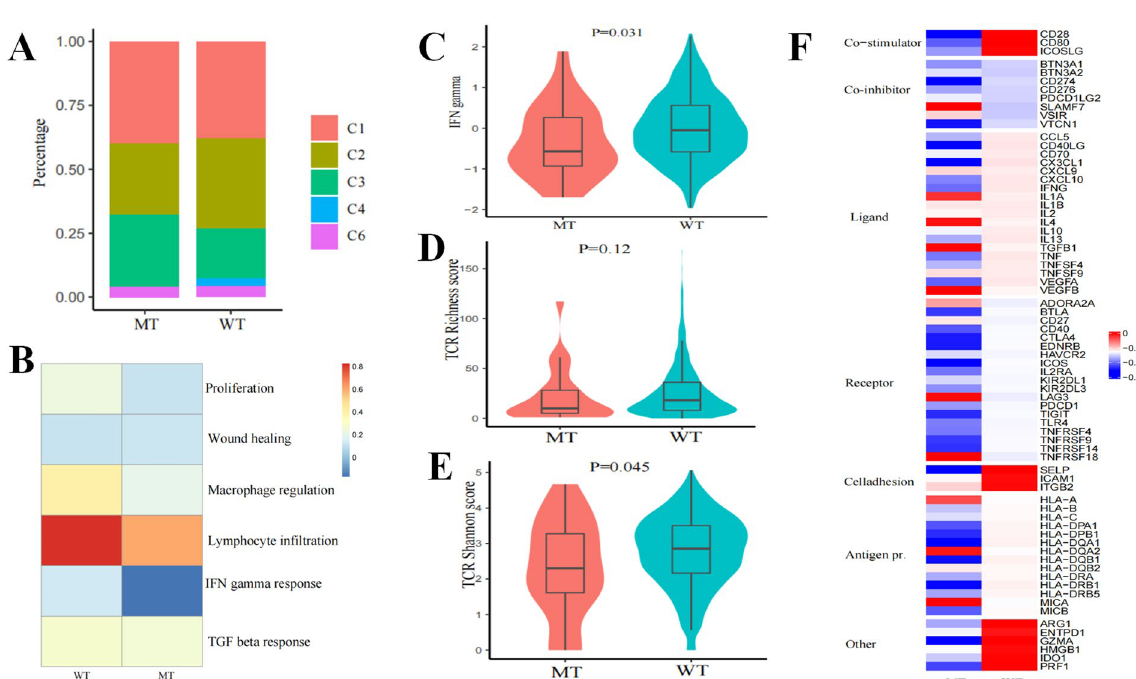
Figure 4. Immunogenomic frame between PBRM1 MT and WT group. ( A ) Composition of six immune subtypes. ( B ) Heatmap of immune expression signatures. ( C ) The difference of IFN-γ signature estimated by TIDE algorithm. ( D ) and ( E ) Box plots for TCR richness and TCR diversity respectively. ( F ) The expression of immune related genes in PBRM1 MT and WT